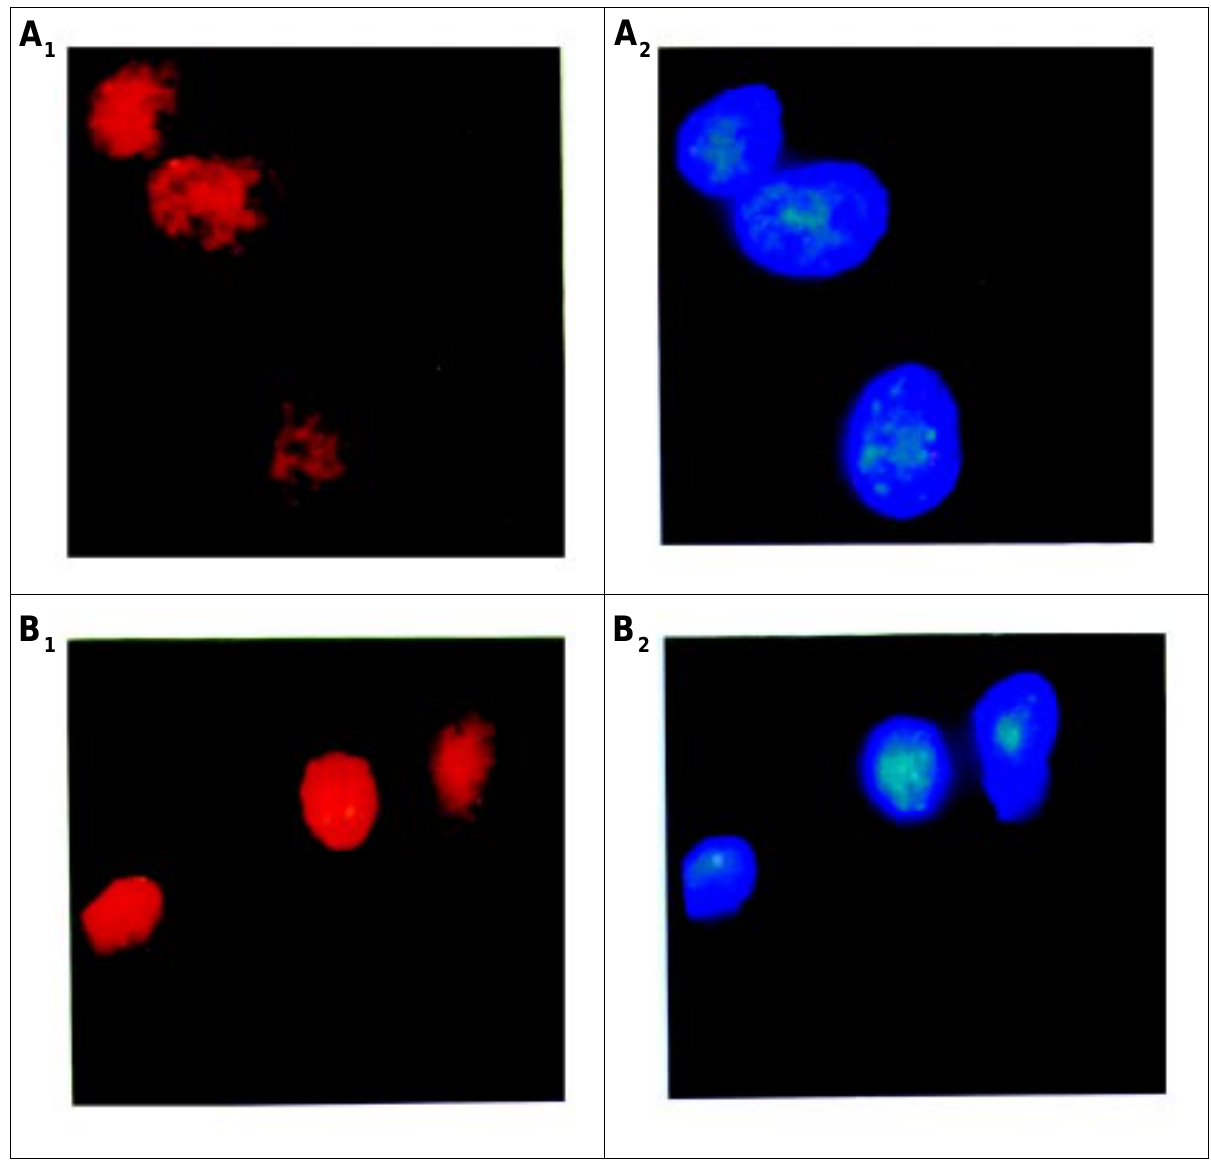
Figure 1 - Two FISH experiments were consecutively performed on the same slides of a patient with prostate cancer. A centromeric probe for chromosome 7 and A centromeric probe for chromosome 7 and B